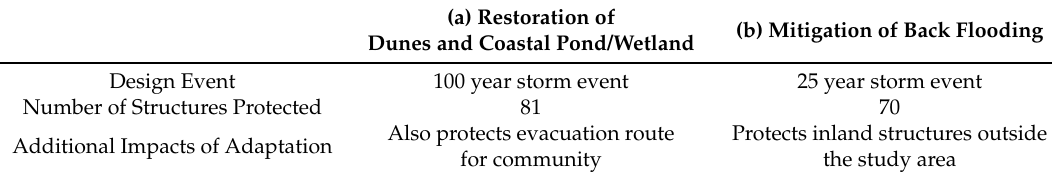
Table 2. Effects of different adaptation measures in terms of structures protected for a given storm